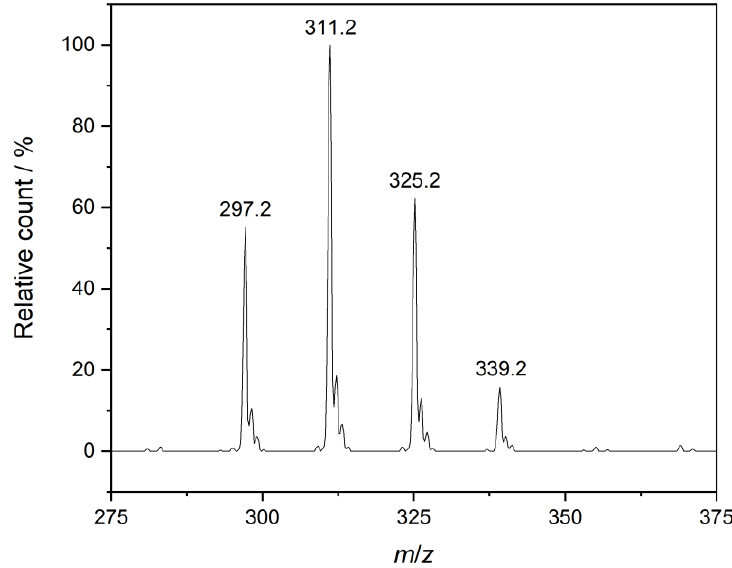
Figure 1. Traces of the negative-ion-mode mass spectrum of an ~0.05 g L – 1 sodium linear alkylbenzene solution. Peaks indicated follow the order of decyl- (CH 3 (CH 2 ) 9 C 6 H 4 SO 3 – , m / z = 297.2), undecyl- (CH 3 (CH 2 ) 10 C 6 H 4 SO 3 – , m / z = 311.2), dodecyl- (CH 3 (CH 2 ) 11 C 6 H 4 SO 3 – , m / z = 325.2), and tridecylbenzene sulfonate (CH 3 (CH 2 ) 12 C 6 H 4 SO 3 – , m / z = 339.2) anions. Based on the relative counts (where the most intense peak of m / z = 311.2 was taken as 100%), the corresponding molar fractions are 23.7%, 42.9%, 26.7%, and 6.8%, respectively.